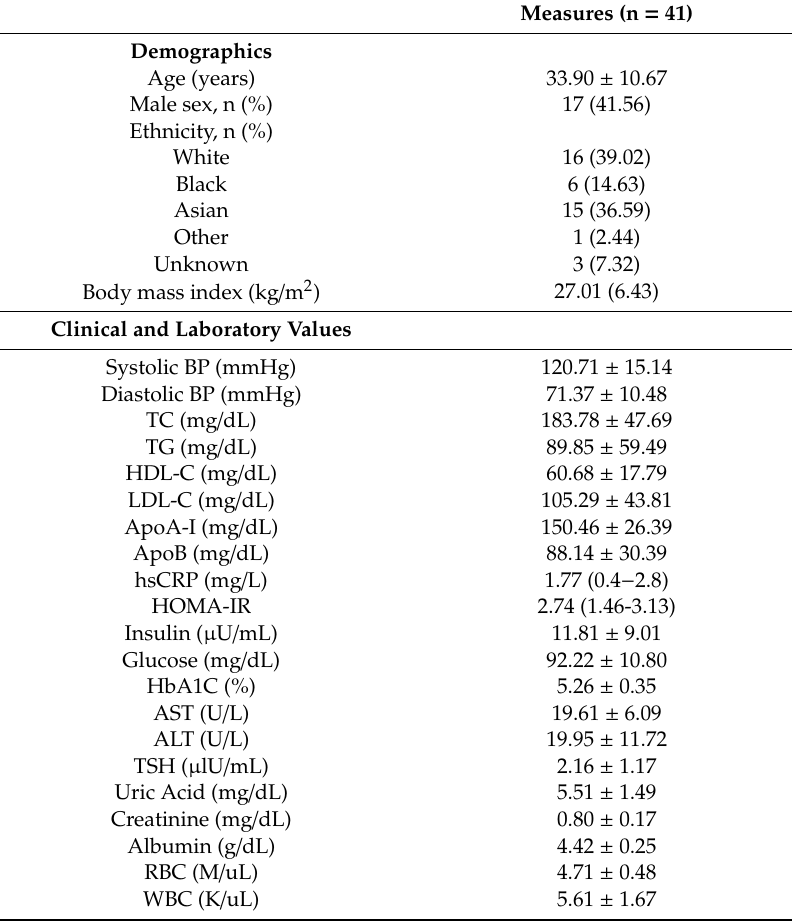
Table 2. Baseline characteristics of